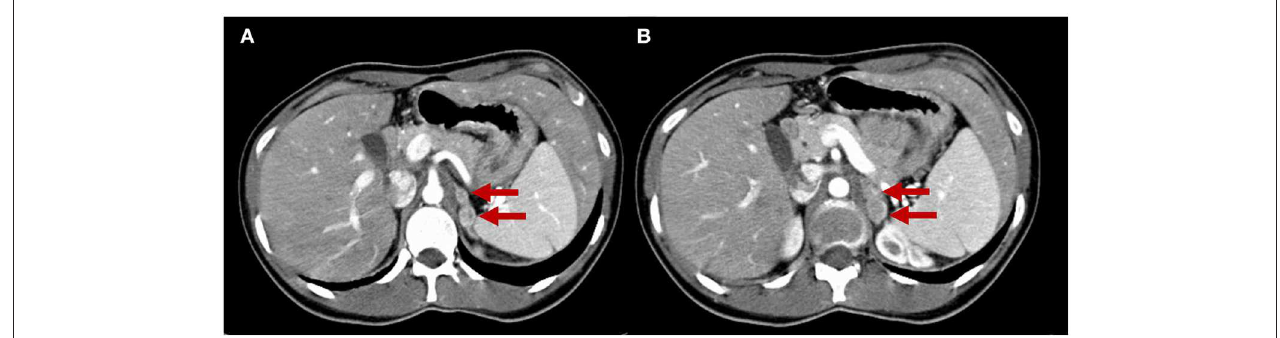
FIGURE 4 | Adrenal CT scan. The two slices (A,B) show four nodules in the left adrenal gland measuring from 10 to 18mm that are unattenuated after contrast administration (red arrows), compatible with left multifocal adrenal